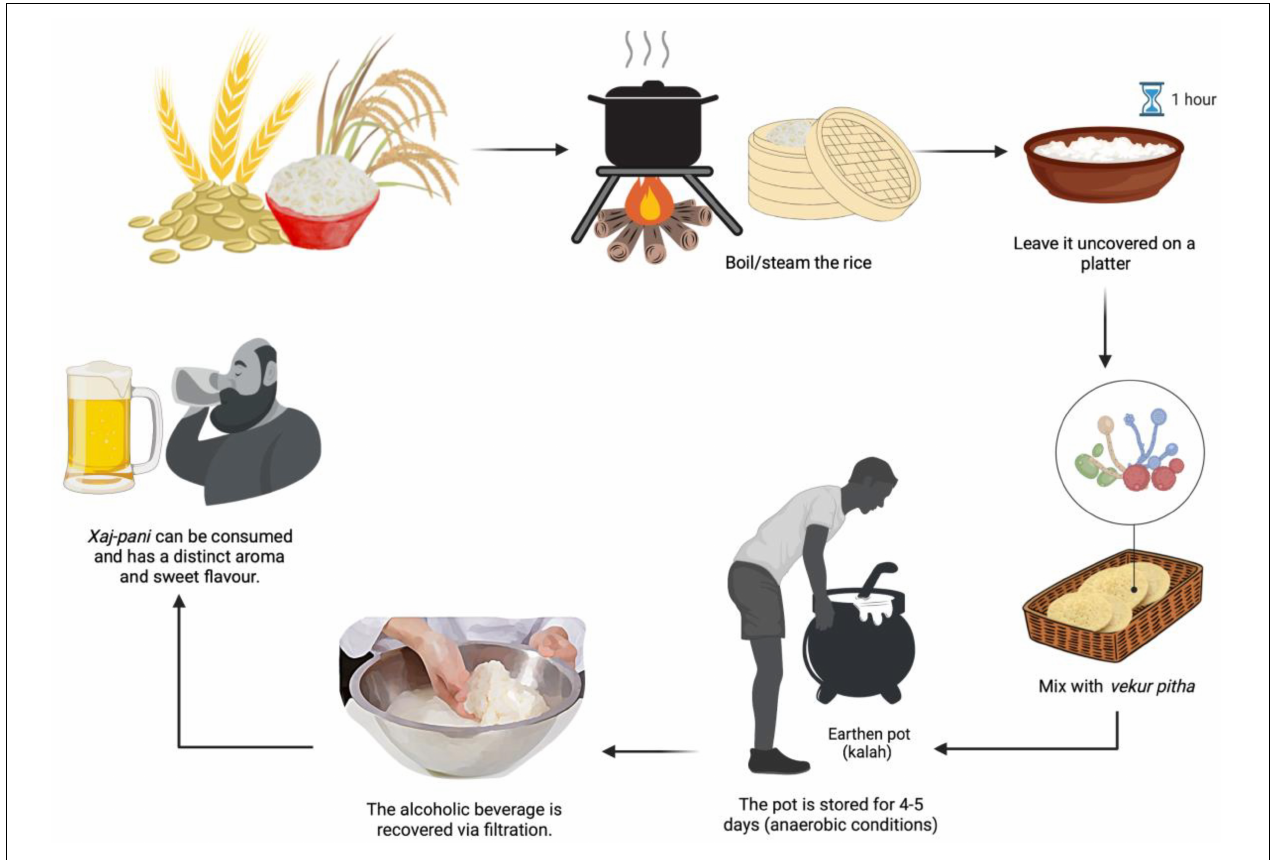
FIGURE 5 | Process of “Xaj-pani”